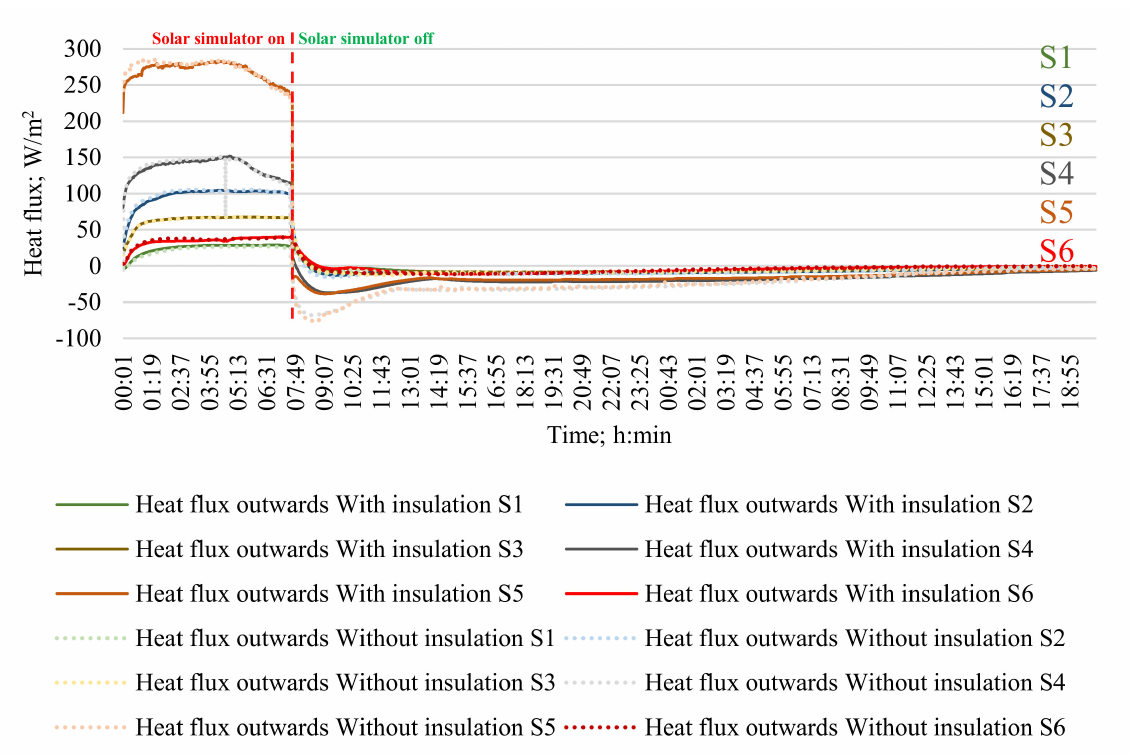
Figure 12. “Indoor” temperature in six setups with insulation applied “at night”.